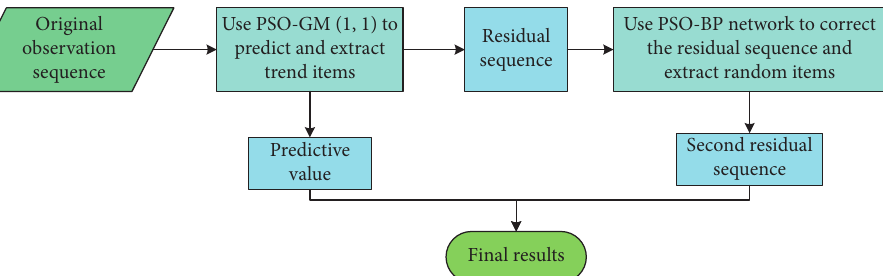
Figure 5: PSO-GM (1, 1) and PSO-BP network combination